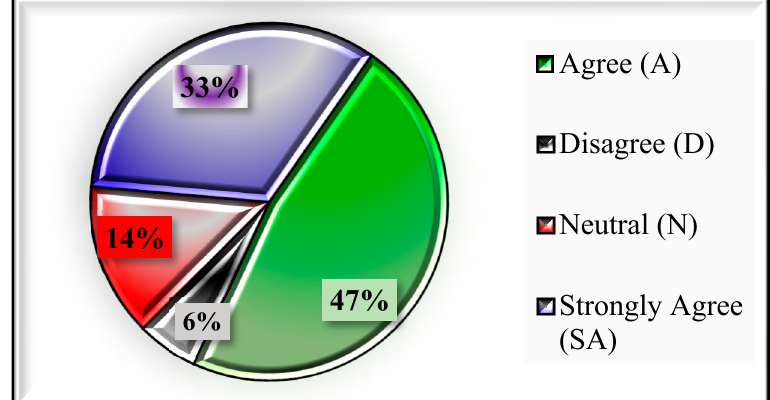
Figure 1. Frequency analysis .